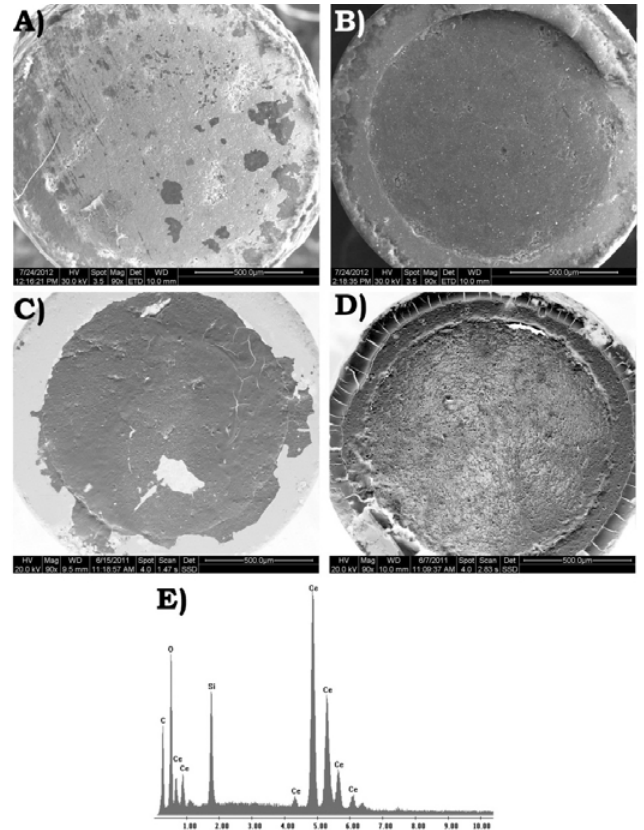
Figure 9. SEM micrographs and example of EDS corresponding to different configurations (0.75 mg·mL − 1 )-modified SNGC of the SNGC electrodes used and not used: CeO 2 electrode ( A ) used and ( B ) not used, both obtained with the secondary electron detector; (10.0 mg·mL − 1 )-modified SNGC electrode ( C ) used and ( D ) not used, both obtained CeO 2 with the backscattered electron detector; ( E ) X-ray EDS corresponding to the CeO 2 nanoparticles film deposited on the surface of a SNGC electrode. All the micrographs were obtained at the magnification of 90× and operating in the range of 24–30